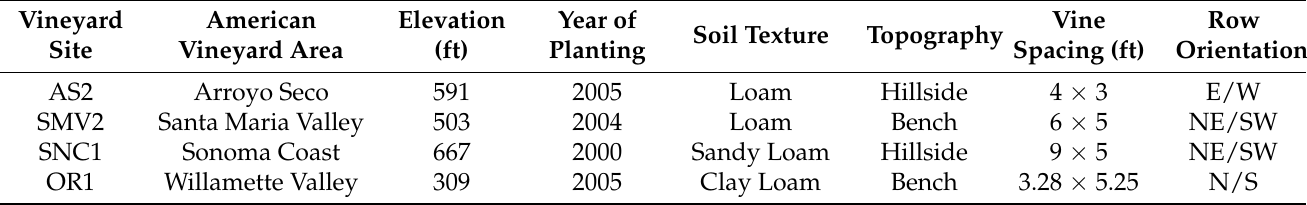
Table 1. Vineyard information and viticultural details for on each site included in this study. Including American Vineyard Area, elevation, year of planting, soil type, topography, vine spacing, and row orientation. Vineyard Site